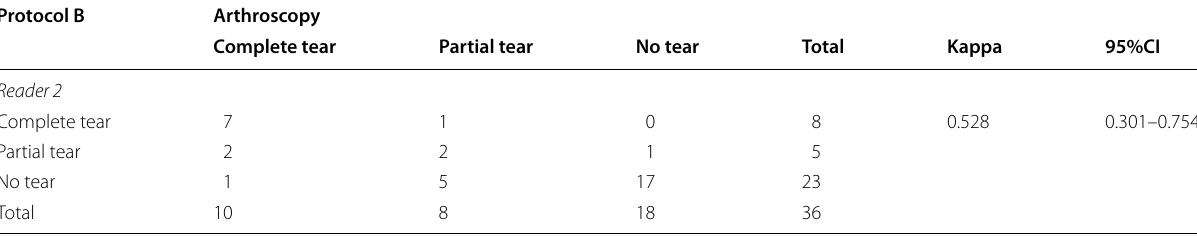
Table 6 MRI grades of ACL graft injury in imaging protocol B versus arthroscopy according to reader 2. Diagnostic agreement between MR grade and arthroscopic grade is also